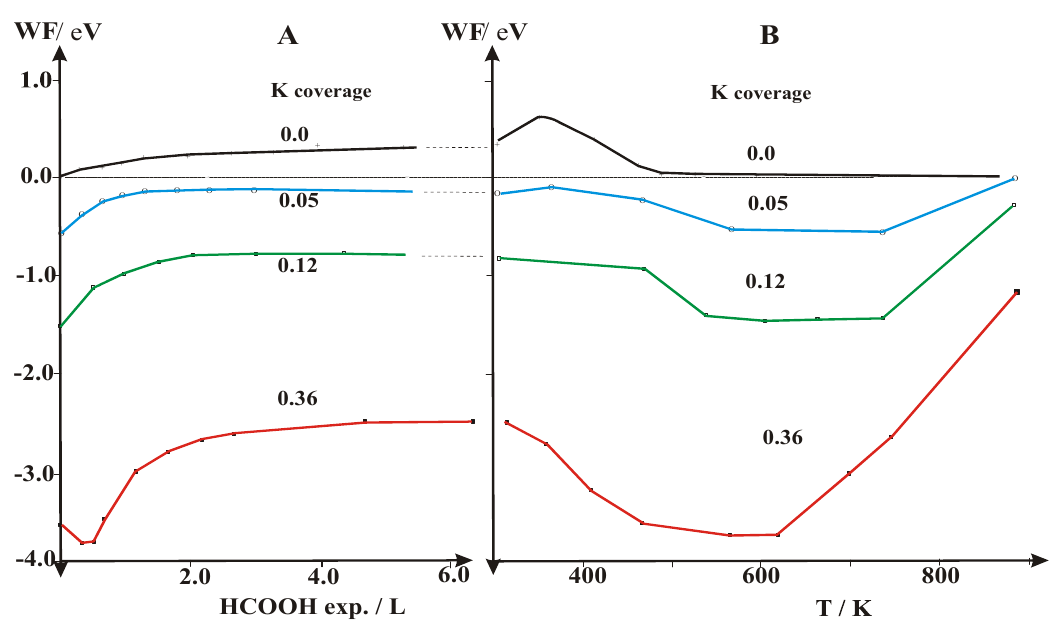
Figure 5. ( A ) Change of the work function, ( ∆ φ ), at di ff erent potassium coverage with FA exposure. ( B ) Change the work function during heating the adsorbed layer.